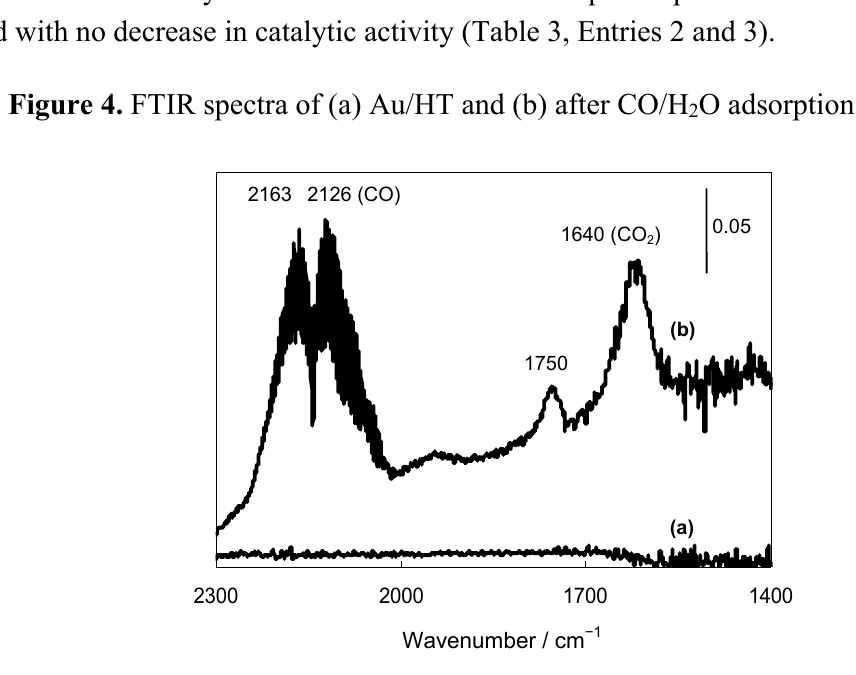
Figure 4. FTIR spectra of (a) Au/HT and (b) after CO/H